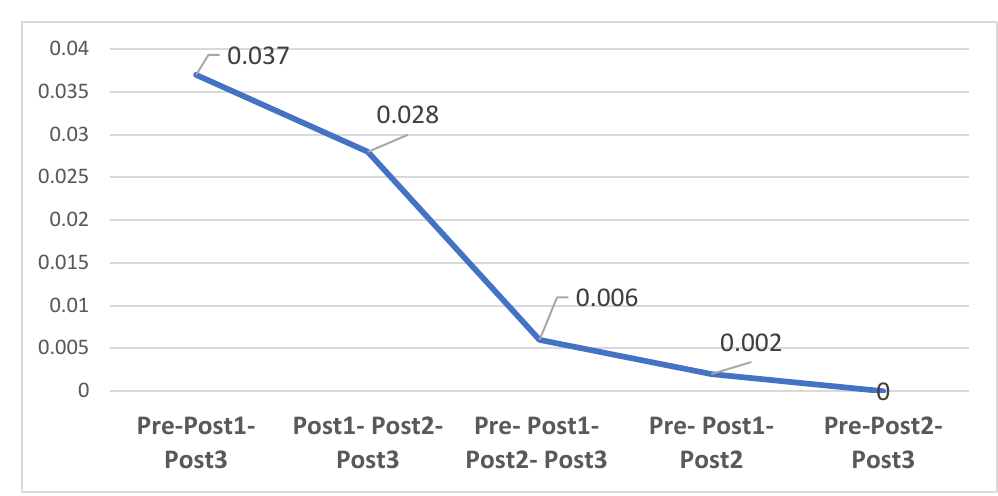
Figure 6. Partial Eta Squared for Effects of the Interaction between Group and Gender.